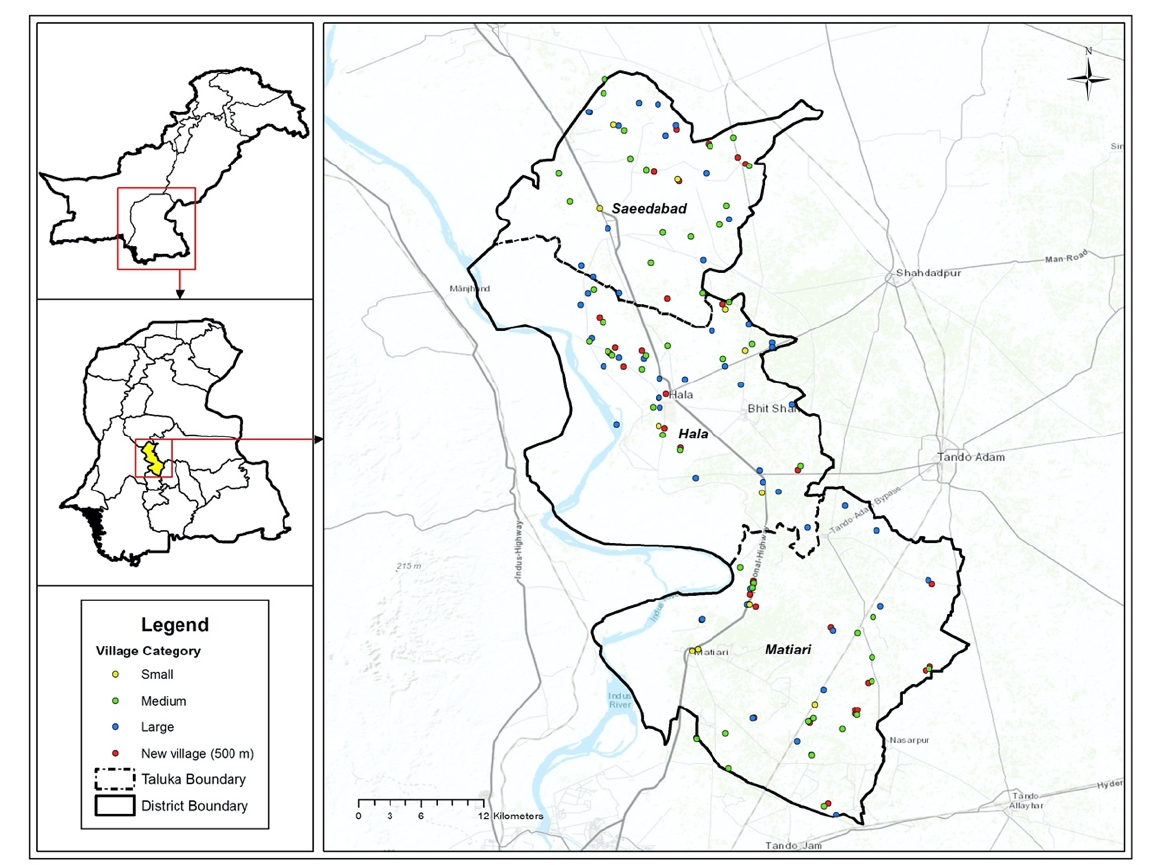
Figure 1. Map of Villages Surveyed in Matiari.